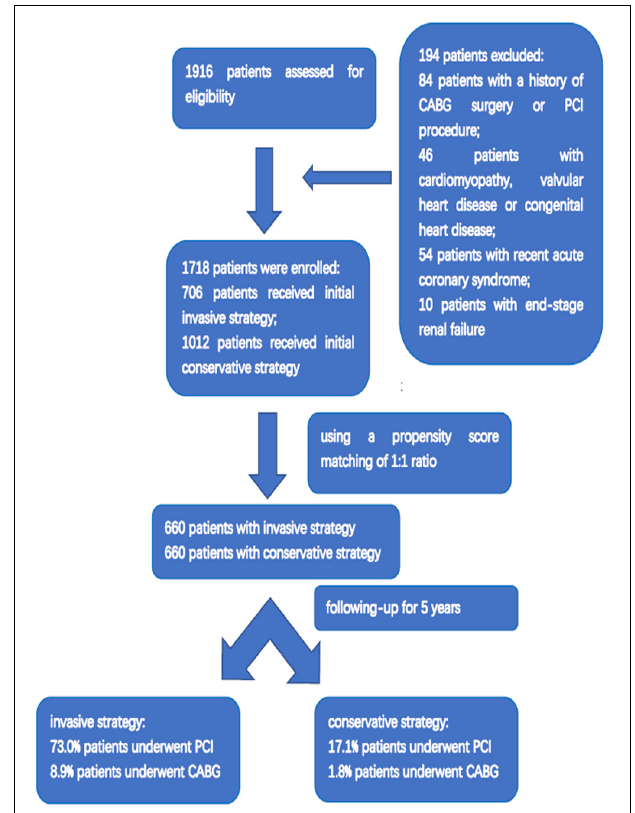
FIGURE 1 | Flowchart of the study